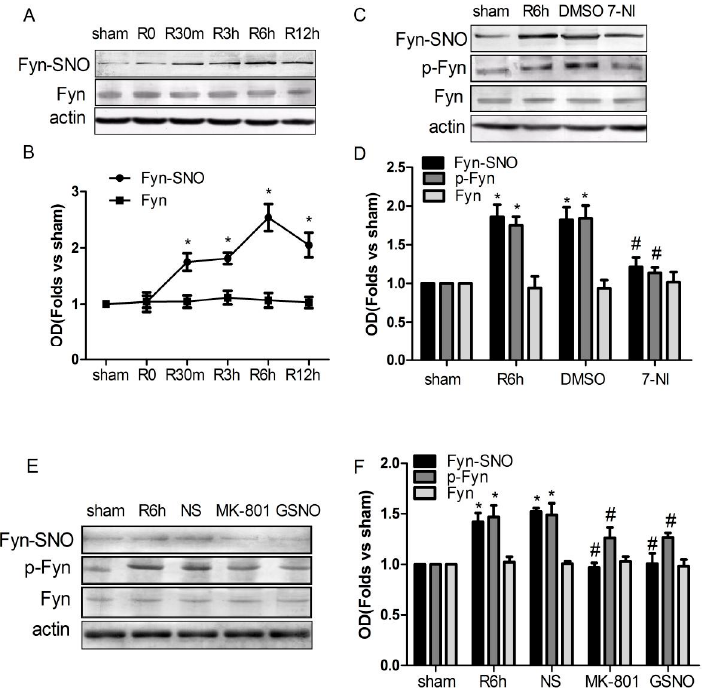
Figure 2. The N -methyl- D -aspartate receptor (NMDAR)/ nitric oxide synthase (nNOS) signaling module may have been involved in the S-nitrosylation and phosphorylation of Fyn. ( A , B ) Time course of S -nitrosylated Fyn levels in hippocampal CA1 in rats after sham treatment or 15 min of ischemia at different time points during reperfusion. * p < 0.05 vs. sham; ( C , E ) Effects of 7-NI, MK-801 and GSNO on Fyn S -nitrosylation and phosphorylation at 6 h of reperfusion after ischemia. The levels of phosphorylated and total Fyn were determined by immunoblotting using antibodies specific for phosphorylated and total Fyn, respectively; ( D , F ) Relative levels of S -nitrosylated, phosphorylated and total Fyn compared with the sham group. Data are presented as the means ± S.D. ( n = 4). * p < 0.05 vs. sham, # p < 0.05 vs. the corresponding solvent-treated control group.